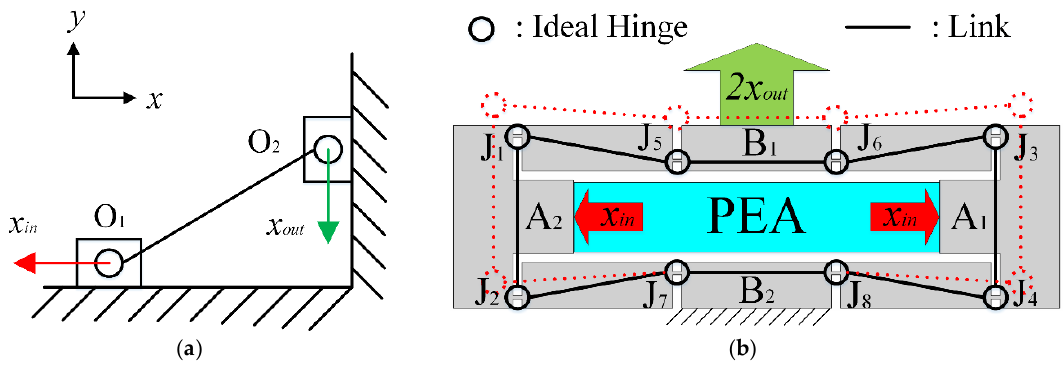
Figure 4. PRB model of the bridge-type amplification mechanism: ( a ) Working principle, and ( b ) overall scheme. (PRB model: pseudo-rigid-body model, PEA: piezoelectric actuator)